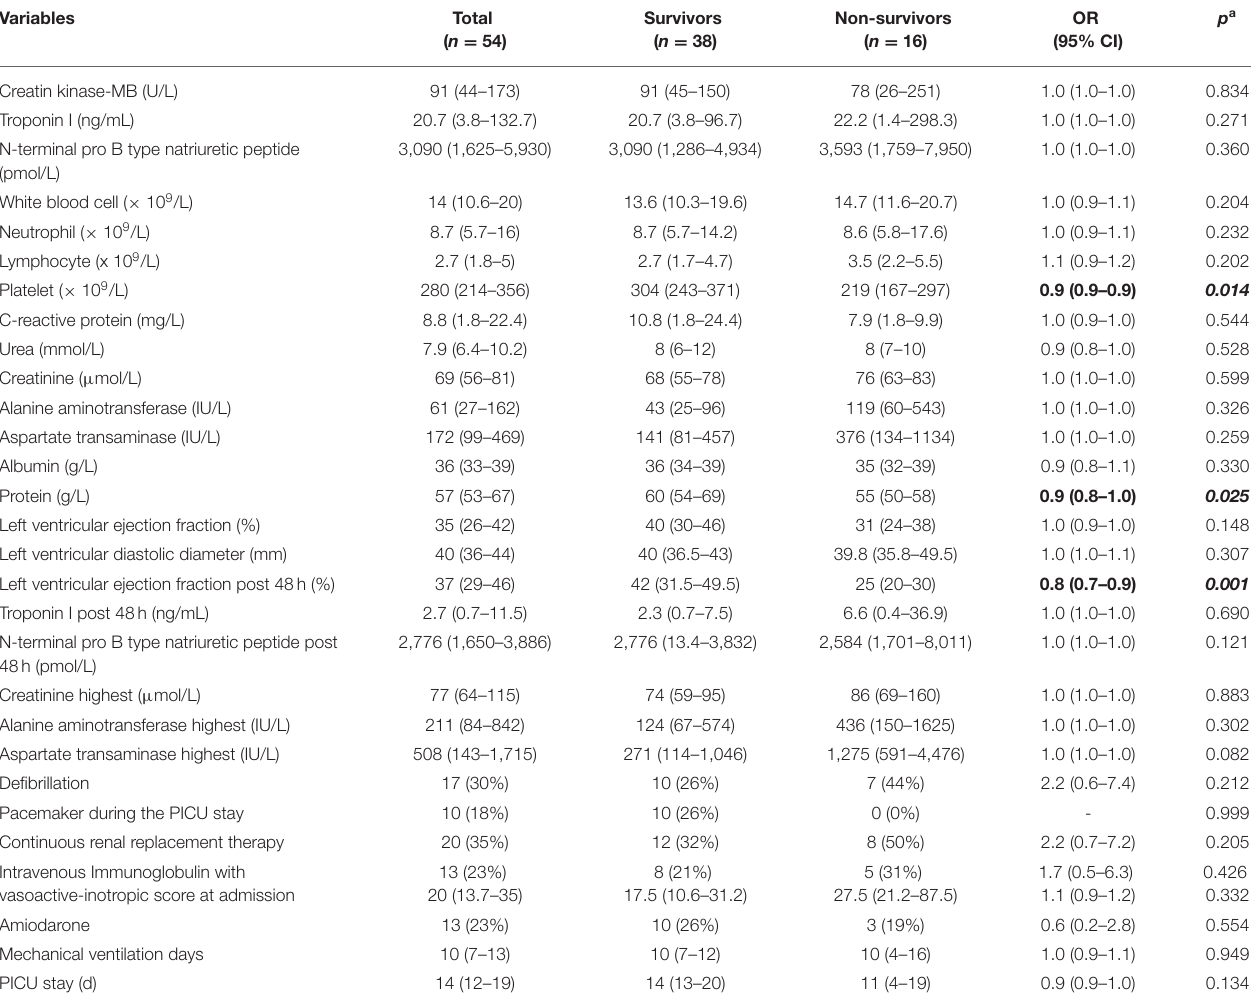
TABLE 2 | Comparison between survivors and non-survivors in terms of laboratory data at admission, organ dysfunction, and treatments during the pediatric intensive care unit stay.